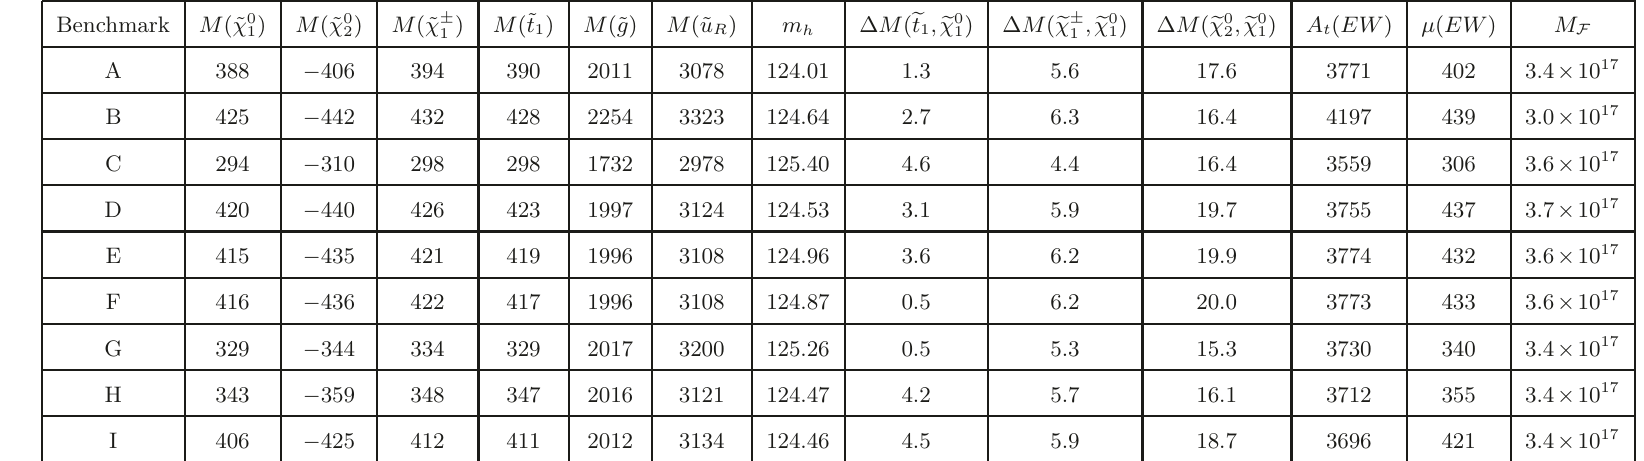
-SU(5) D-brane inspired naturalness region. F